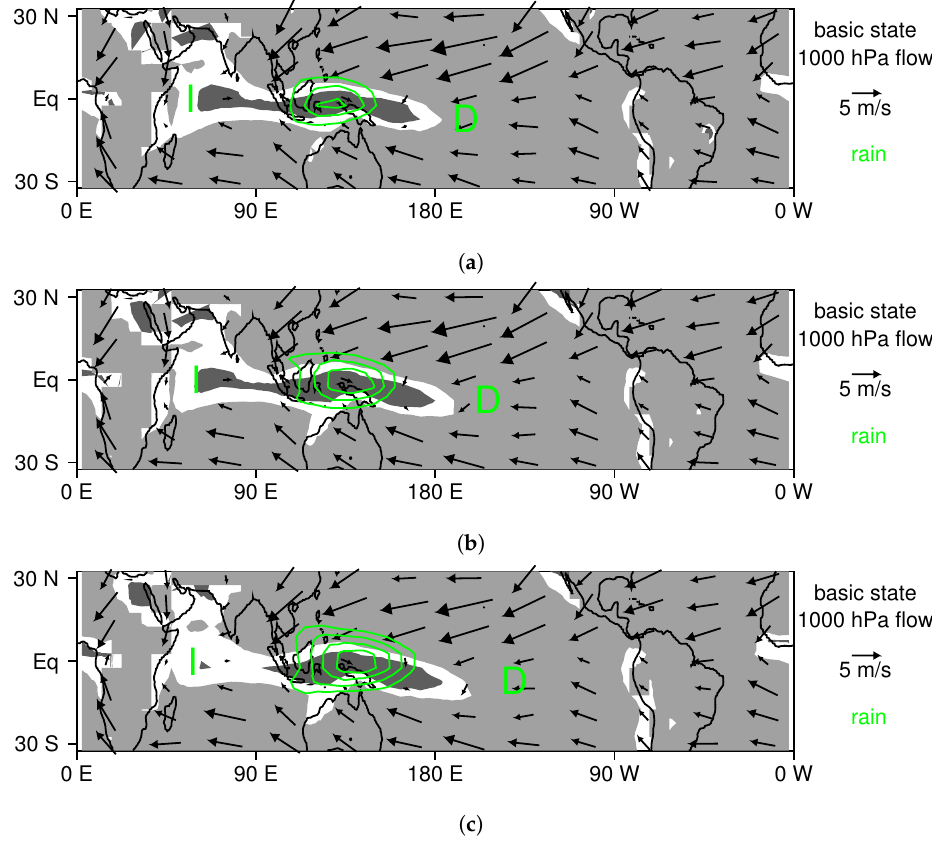
Figure 6. Basic state 1000 hPa flow for the active season of the MJO: ( a ) the control simulation; ( b ) the 3 K warming experiment; and ( c ) the 7 K warming run. Regions where westerly (easterly) wind components exceed 1 m/s in amplitude are shaded dark (light) gray. Perturbation rainfall is contoured in green for 3, 5, 7, and 9 mm/day for the time when the composite MJO is in the middle of its track (i.e., at the mature stage). The letter “I” indicates the starting longitude of the initiating stage, and the letter “D” indicates the finishing longitude of the dissipating stage for the mean MJO track (i.e., the mean MJO track spans longitudes between I and